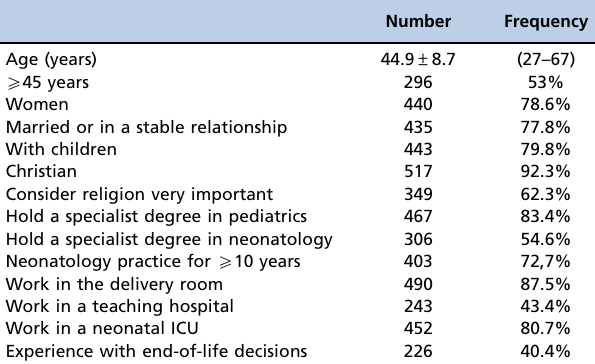
Table 1 - Demographic characteristics of the